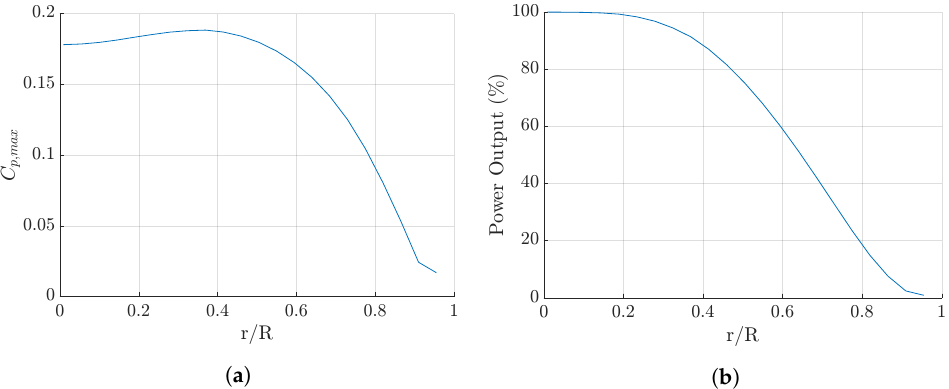
Figure 25. Effect of blade length on rotor power output and C p , max . ( a ) C p , max ; ( b ) Power output. It can be seen from Figure 25a that the largest value of C p , max is obtained when the blades start at a radius that is located at 37% of the outer radius, i.e., the blade length is 63% of the rotor radius. On the current Daisy Kite prototype, an r / R value of 0.37 corresponds to a blade length of 1.4